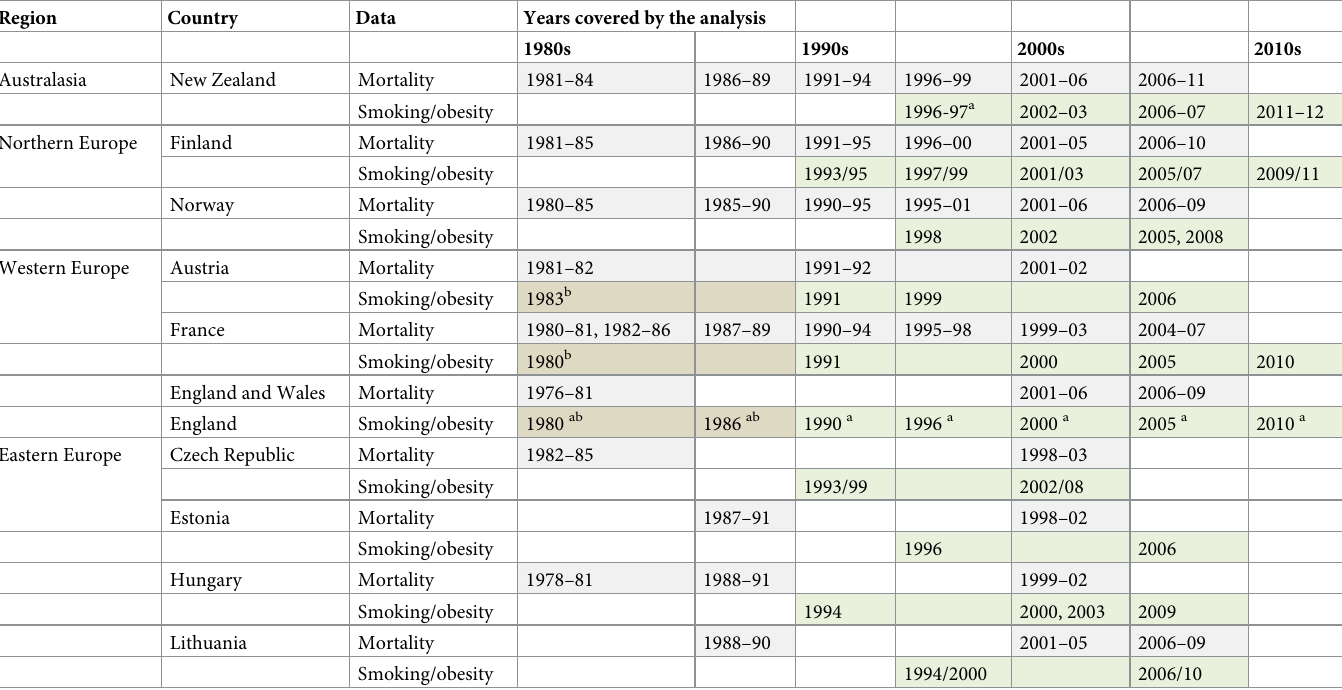
Table 1. Country data for socioeconomic inequalities in mortality and smoking/obesity prevalence by